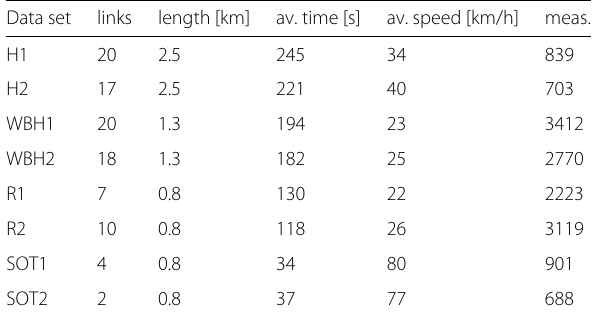
Table 2 Characteristics of the selected routes (numbers rounded) Data set